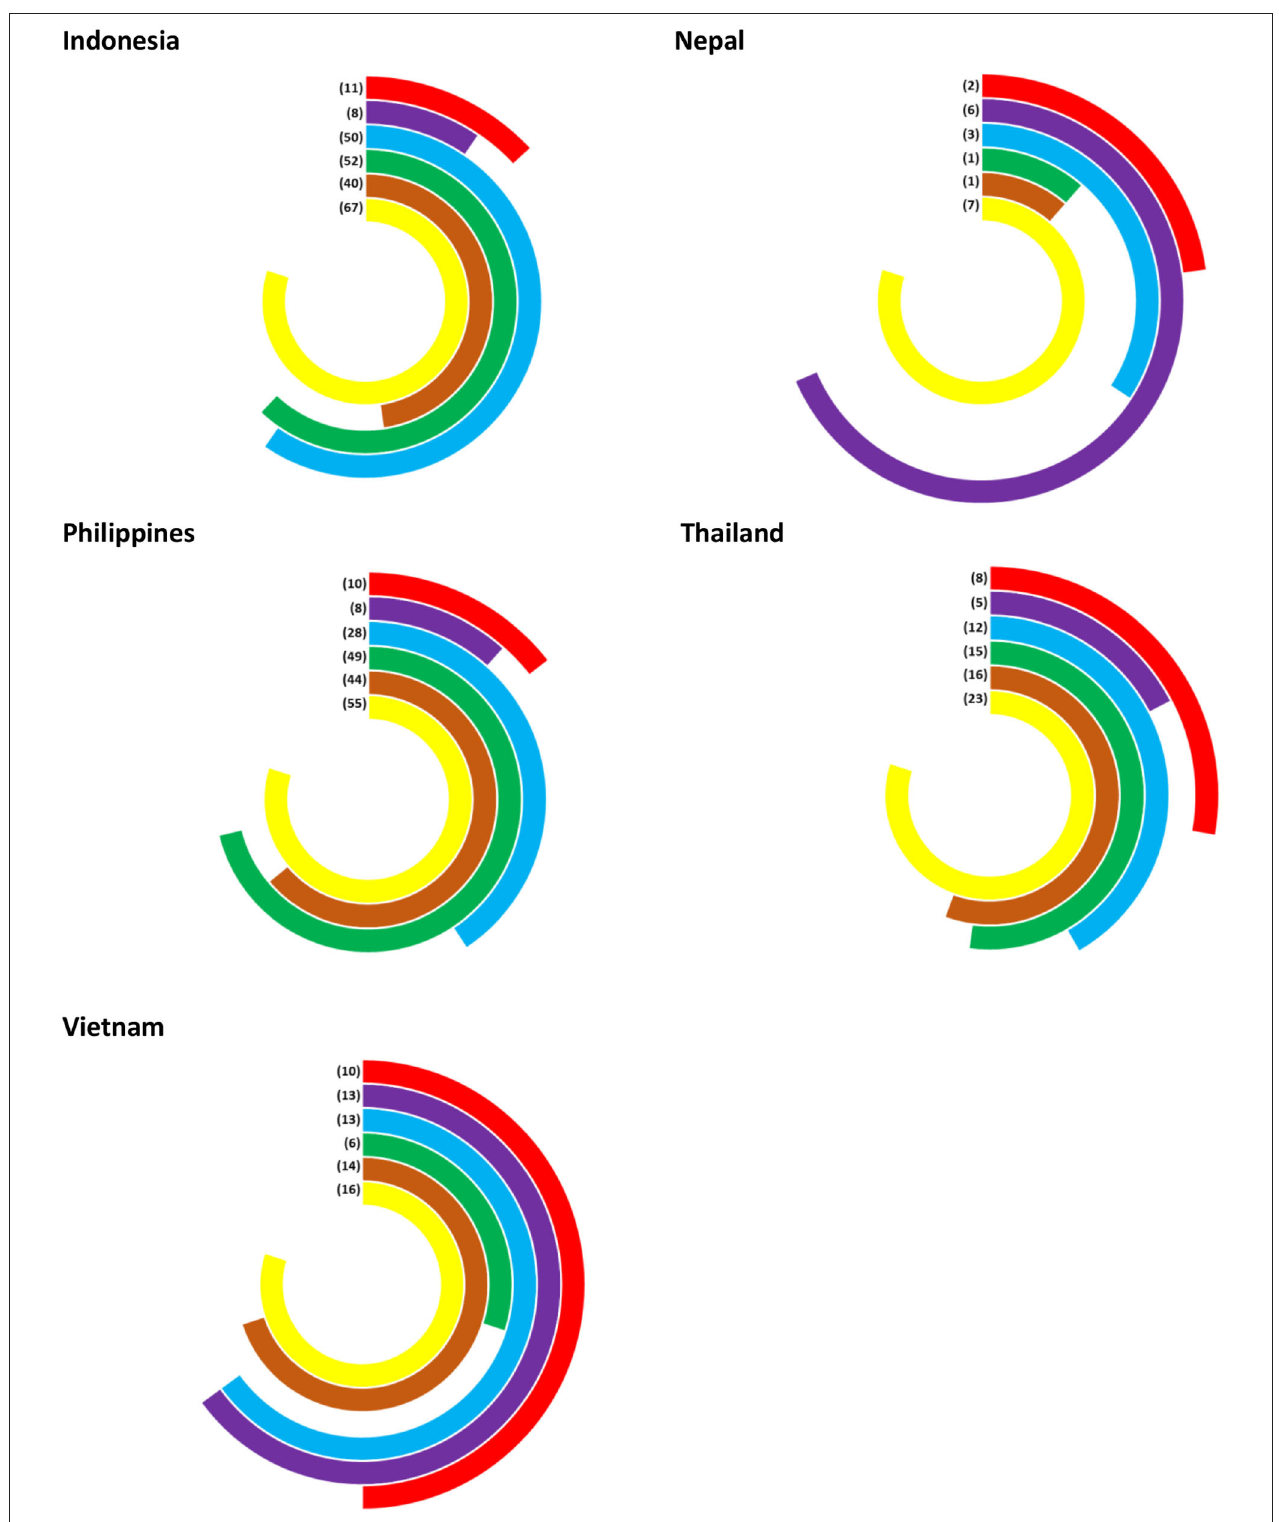
FIGURE 4 | Country-level progress of biological control science along a six-step, outcome-oriented “impact pathway.” Within each chart, the number of scientific publications covering a given theme is indicated next to the respective loop. The inner-most circle reflects relative scientific attention to biodiversity assessments; the outer-most circle captures social-economic